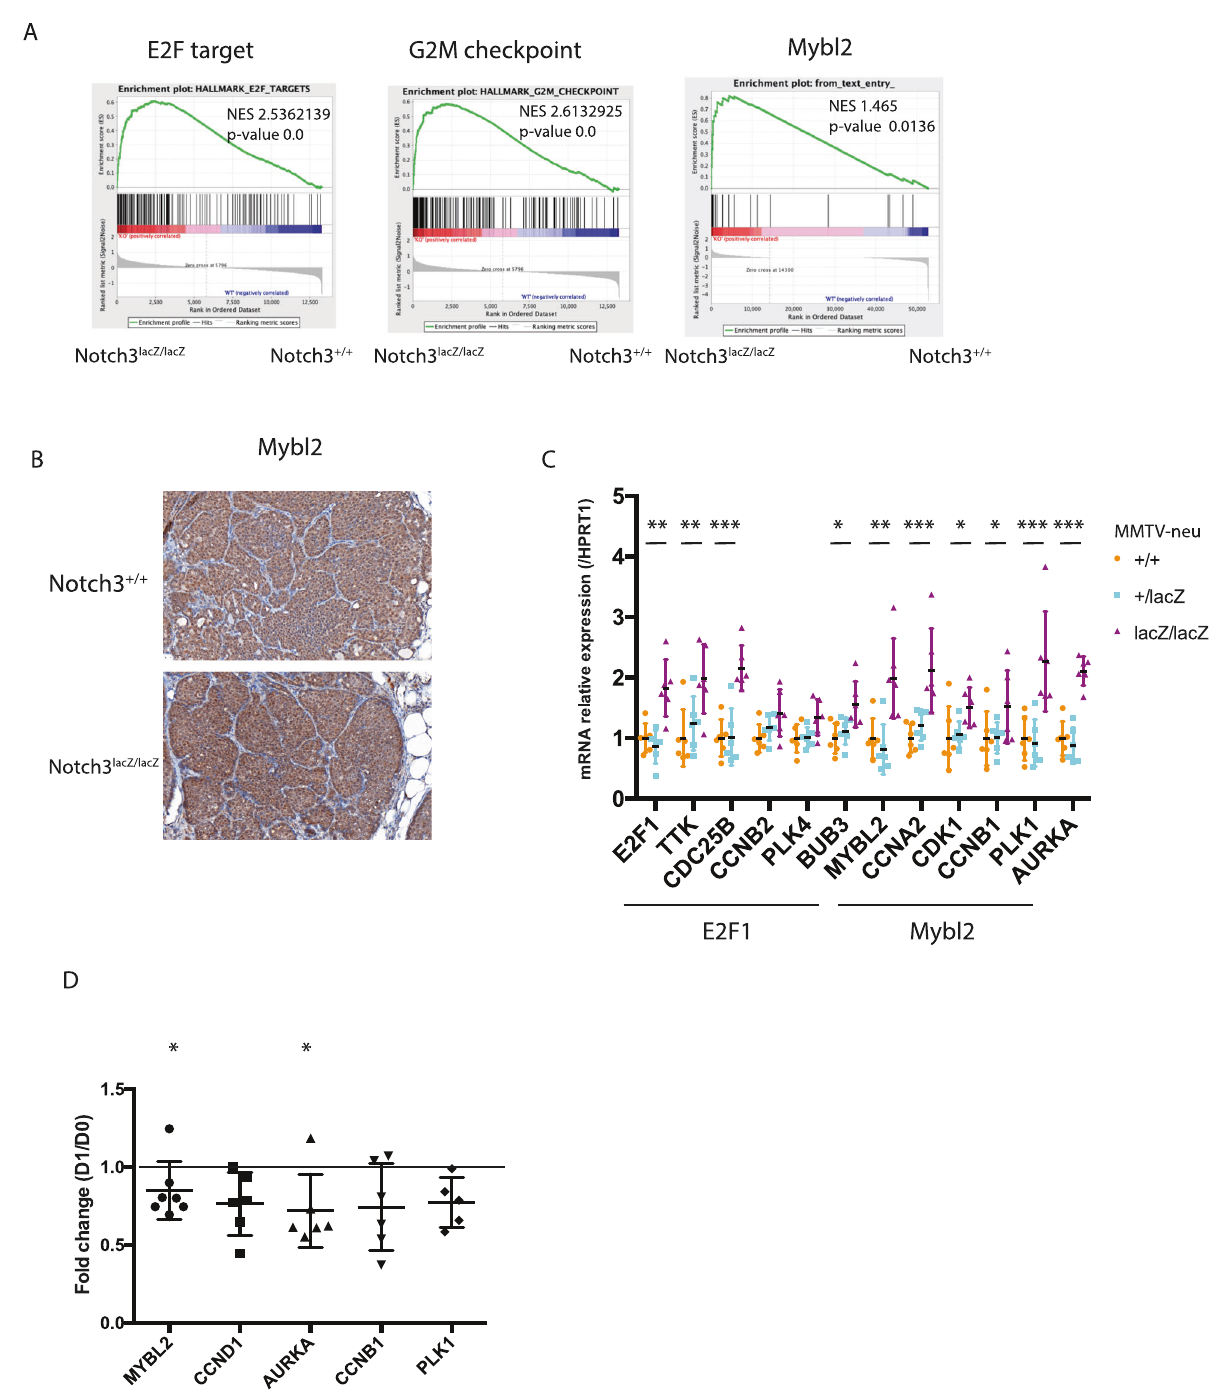
Fig. 4 Notch3 is regulating a Mybl2 signature in mammary gland tumors. A GSEA analyses of E2F target, G2/M Checkpoint and Mybl2 signature comparing Notch3 wt and Notch3 null (Notch3lacZ/lacZ) tumors in MMTV-Neu induced tumors. B Immunohistochemistry for Mybl2 protein in Notch3 wild type and null tumors. C mRNA expression of E2F1 and Mybl2 targets in tumors dissected from MMTV-NEU; Notch3 + / + ( + / + ), MMTV-NEU; Notch3 lacZ/ + ( + / – ) and MMTV-NEU; Notch3lacZ/lacZ tumors ( – / – ). D mRNA q-RT PCR analysis of Mybl2 and target genes in organoïds expressing N3ICD upon doxycyclin treatment (D1). Expression is expressed as fold change between N3ICD expressing and control organoïds of mRNA expression standardize to HPRT1. in MDA-MB231 cells. We could show that HeyL directly binds to of Notch3 in breast cancer cell lines. We next focus on the the promoter of Mybl2 both in 2D and in 3D (Fig. 5E). Importantly, regulation of Mybl2 by HeyL. We therefore looked for Chip-seq the binding of HeyL on Mybl2 promoter was stronger in 3D. data published with HeyL and found that in HEK293T cells, Heisig We fi nally sought the correlation between HeyL and Mybl2 in et al., observed a signi fi cant peak in Mybl2 promoter [26]. We next the TCGA database. Among Notch target genes, HeyL was the looked by chromatin immunoprecipitation upon N3ICD expression Cell Death and Disease (2023)